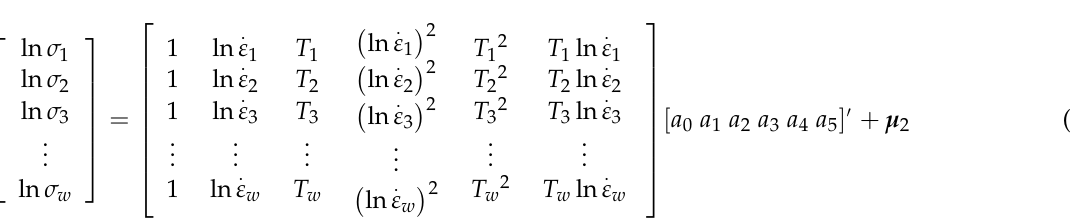
Figure 9. Comparison of prediction fl ow stress and experimental fl ow stress for the quadratic model: ( a ) 0.01 s − 1 ; ( b ) 0.1 s − 1 ; ( c ) 1 s − 1 ; ( d ) 10 s − 1 ; ( e ) 10 s − 1 .